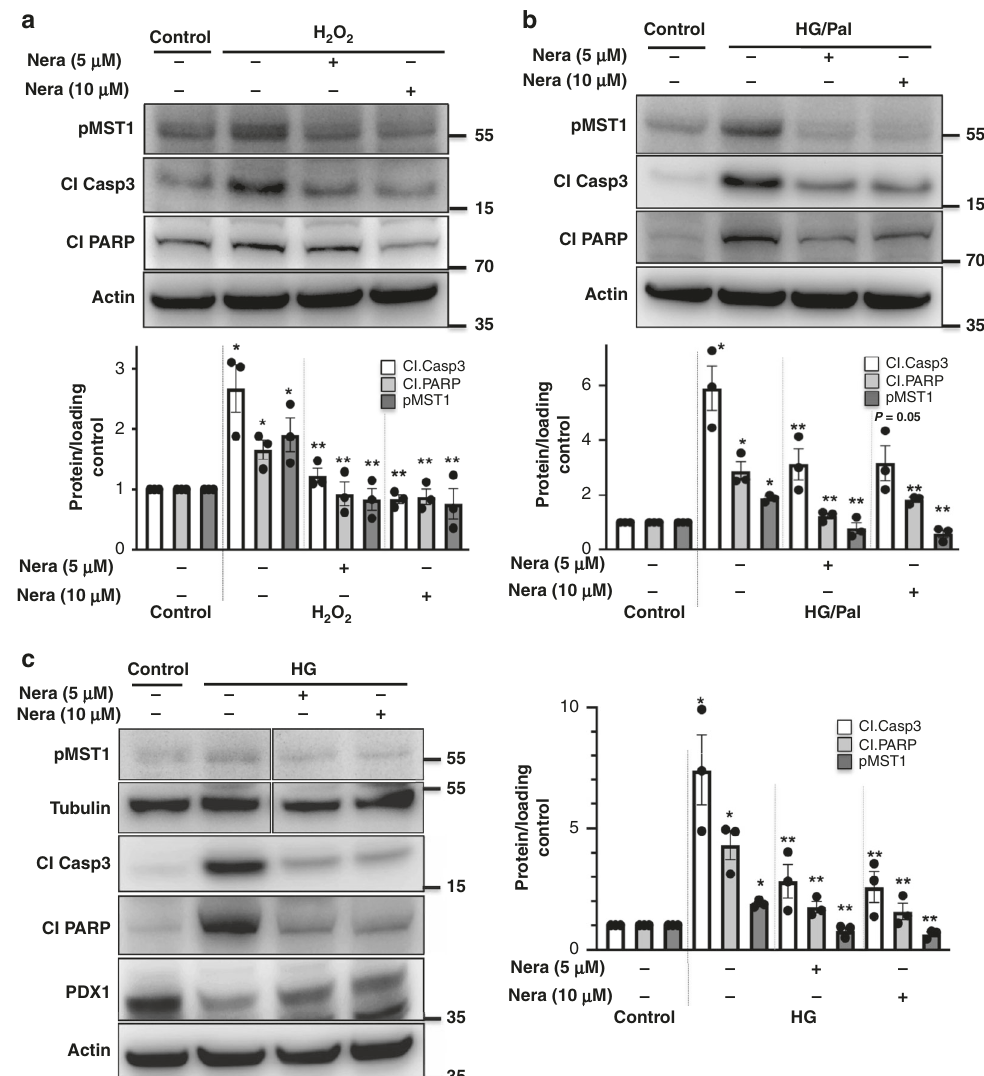
Fig. 2 Neratinib blocks MST1 activation and apoptosis in INS-1E β -cells. INS-1E cells were exposed to diabetogenic conditions ( a H 2 O 2 , b , c 22.2 mM glucose or the mixture of 22.2 mM glucose and 0.5 mM palmitate (HG/Palm)) ± neratinib for 72 h. Phospho-MST1 (pMST1; pThr183), caspase-3 and PARP cleavage, PDX1, tubulin, and actin were analyzed by western blotting. Representative Western blots and pooled quantitative densitometry analysis are shown from three independent cell line experiments ( n = 3). Results shown are means ± SEM. * p < 0.05 H 2 O 2 or HG or HG/Pal to control, ** p < 0.05 neratinib to vehicle-treated β -cells under the same diabetogenic conditions; all by Student ’ s t tests. Source data are provided as a Source Data fi